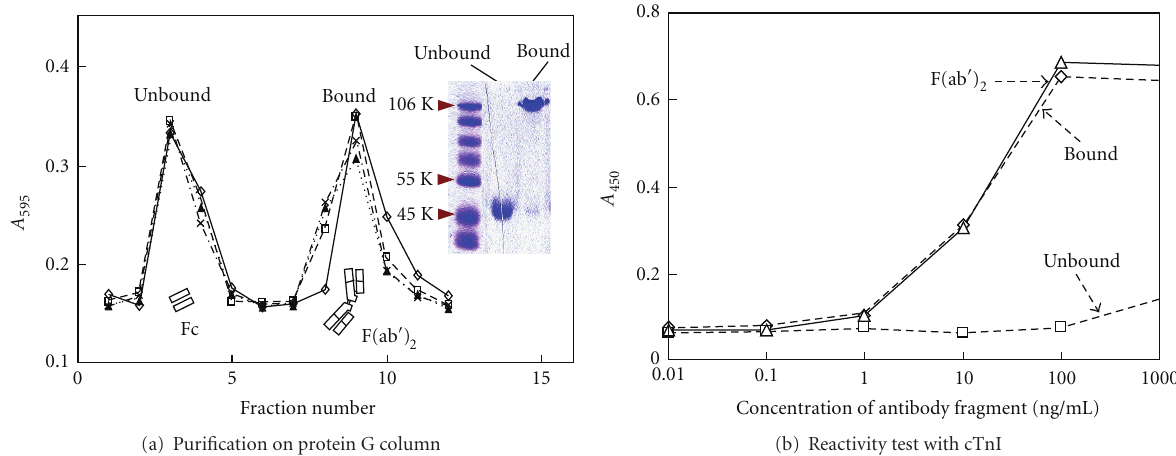
Figure 2: A ffi nity purification of the digested fragments of IgG type antibody on a protein G column and their characterization. Elution fractions from the column were analyzed for total protein by means of a Bradford assay (a). The fractions in each peak were pooled, which were then identified by molecular size via SDS-PAGE under non-reducing conditions (inset, (a). The reactivities of each pooled fraction were subsequently confirmed by solid-phase immunoassays with cTnI as the antigen immobilized on the solid matrix (b)